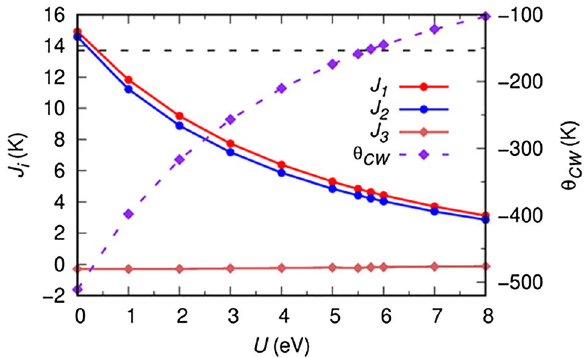
Figure 9. The magnetic exchange-coupling constants of Mn atoms for intra-layer J 1 , and inter-layer J 2 and J 3 as well as θ CW as a function of Hubbard U . The experimental θ CW value (−152 K) is shown as dashed line, which matches the calculation for U = 5.75